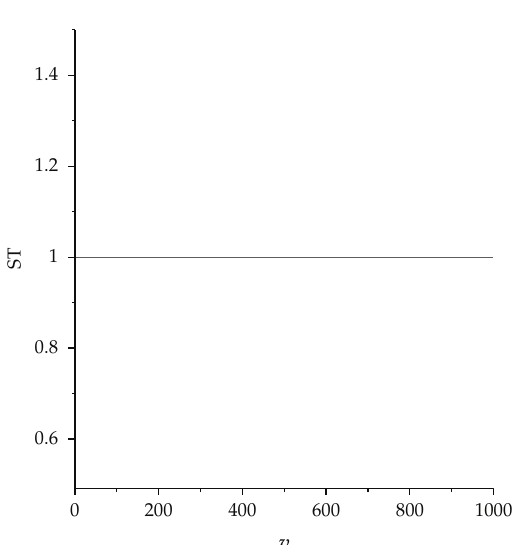
Figure 2: Behaviour of the quantity ST for several values of v